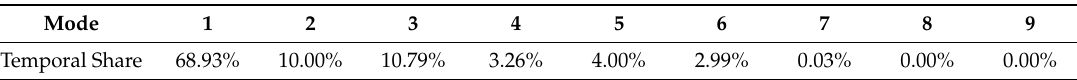
Table 6. Field-test results for the State of Charge control mode in optimized Power Flow Distribution Strategy (Technical Unit 4) from the extended testing timeframe of 14 days in August 2017.